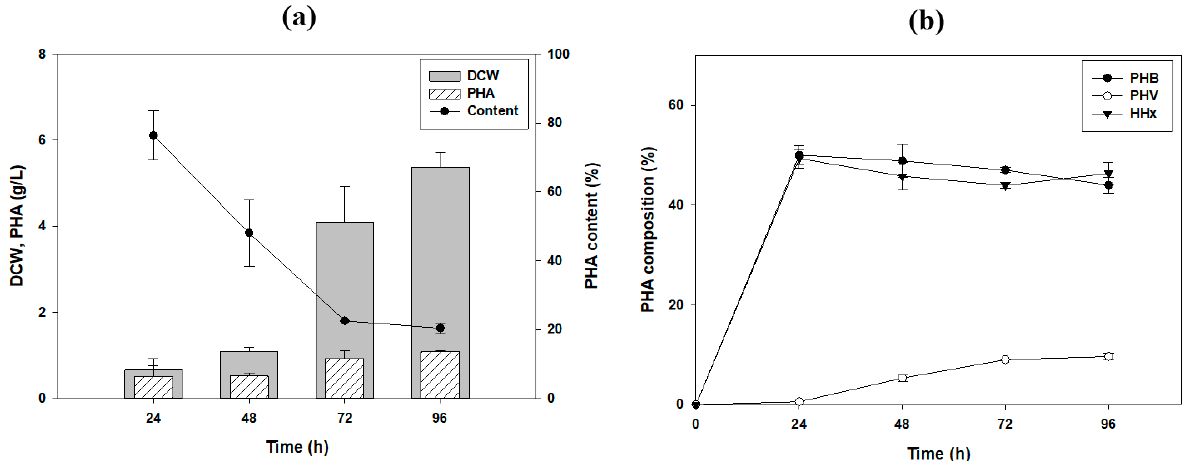
Figure 6. PHA production using tung oil as a carbon source in batch fermentation. ( a ) biomass, polyhydroxyalkanoate (PHA) accumulation, ( b ) PHA monomer composition. 3HB, 3-hydroxybutyrate; 3HV, 3-hydroxyvalerate; DCW, dry cell weight; HHx, 3-hydroxyhexanoate.